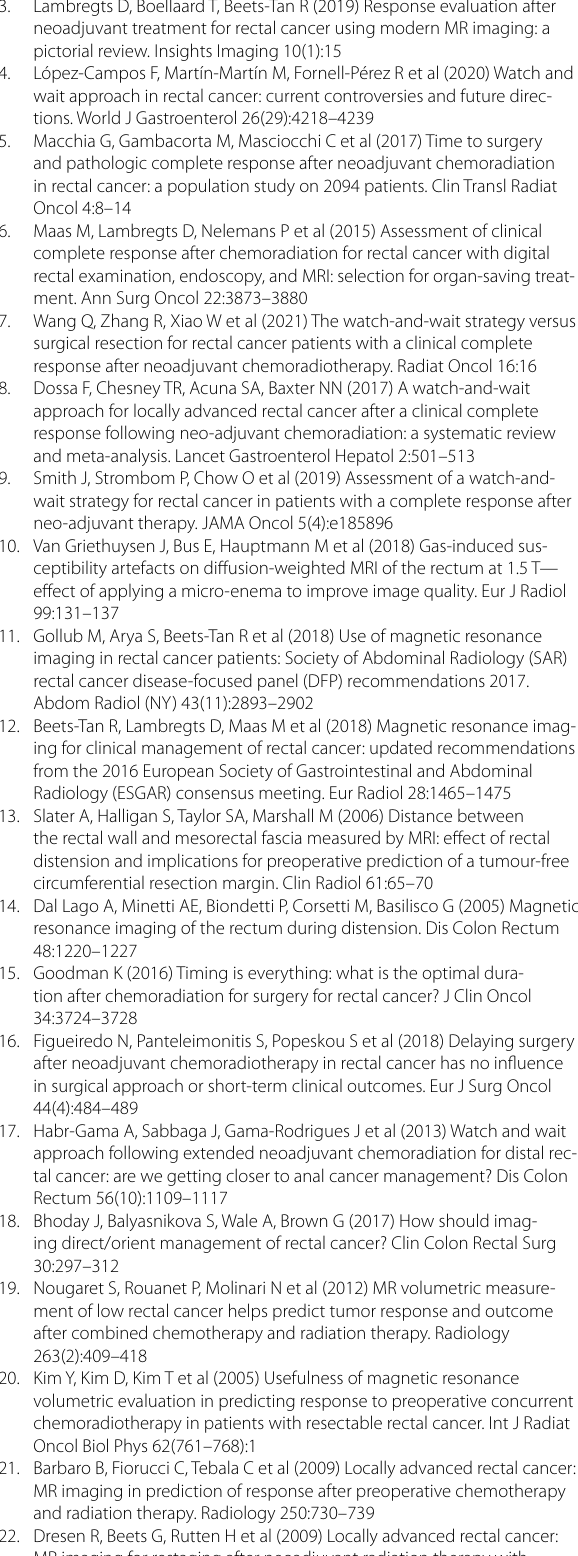
pictorial review. Insights Imaging 10(1):15 4. López-Campos F, Martín-Martín M, Fornell-Pérez R et al (2020) Watch